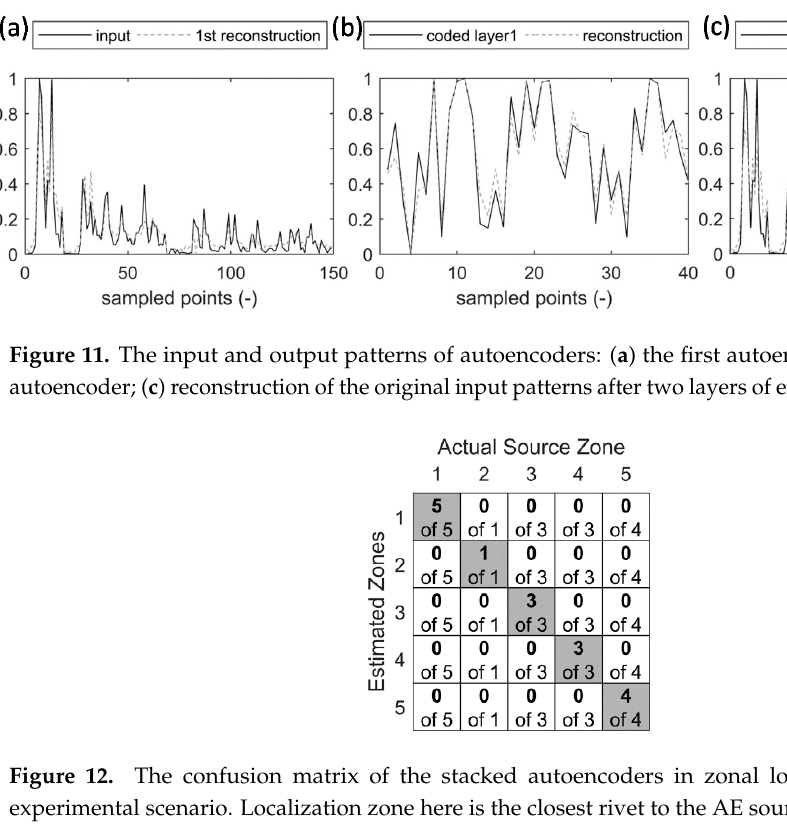
Figure 13. The confusion matrix of the stacked autoencoders in zonal localization of the second experimental scenario.